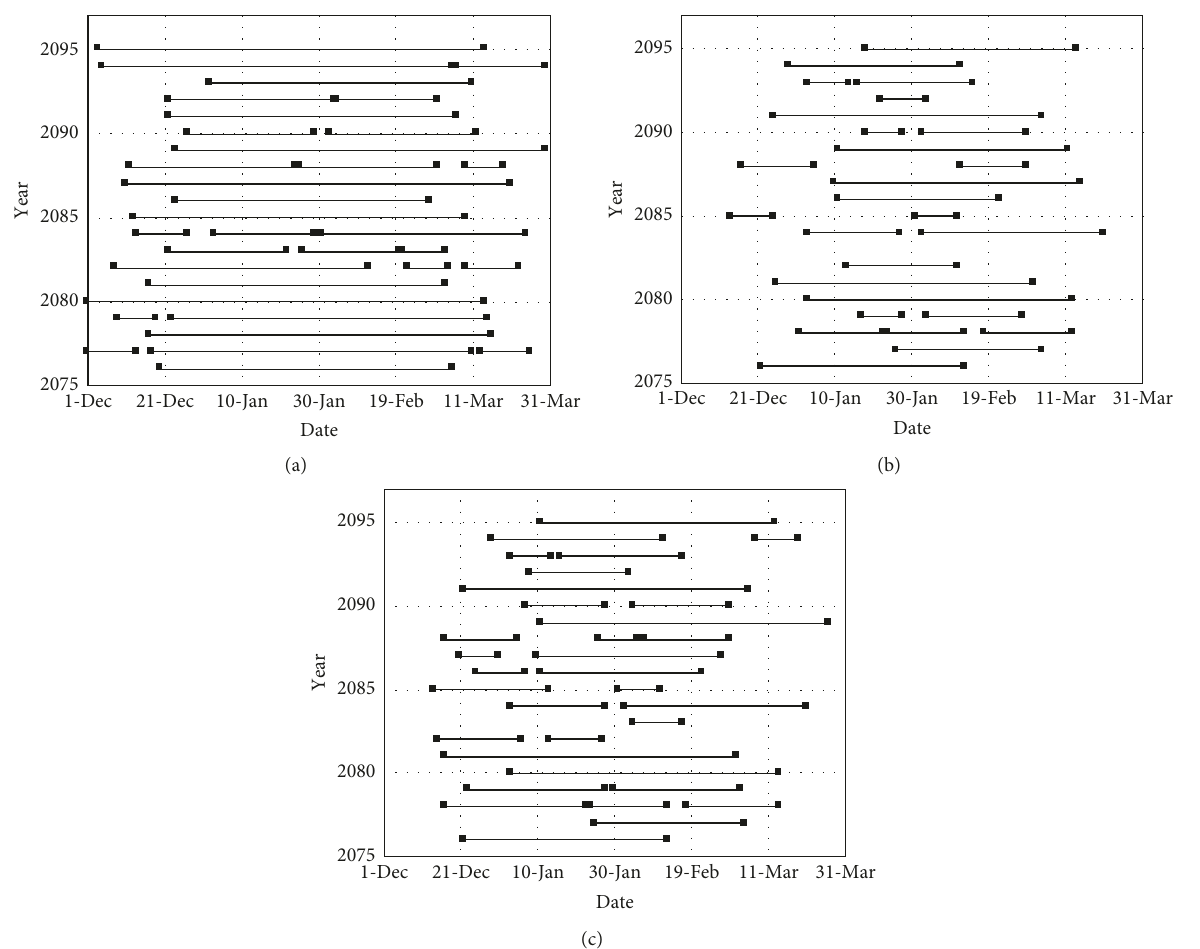
Figure 7: Projected skiable periods (see Section 3.3 for details) with artificial snow supply for future period (2076–2096 under the MME SST pattern). (a) Field A. (b) Field B. (c) Field C.